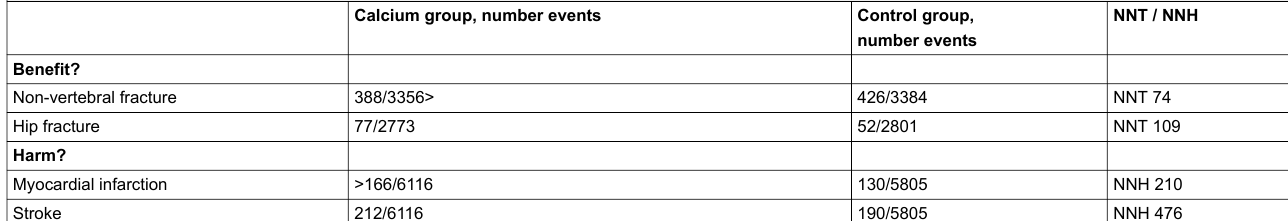
Table 1: Benefits and risks of calcium supplementation. Treatment effect estimation (NNT/NNH) based on data from published meta-analyses evaluating the effect of calcium supplements on fracture risk and cardiovascular events (treatment duration 4–5 years) [1, 10, 63]. Calcium group, number